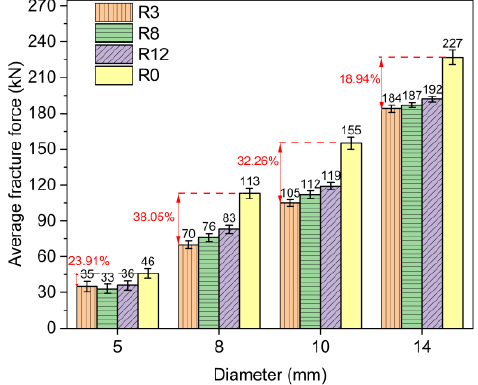
Figure 6. Average fracture force histogram of